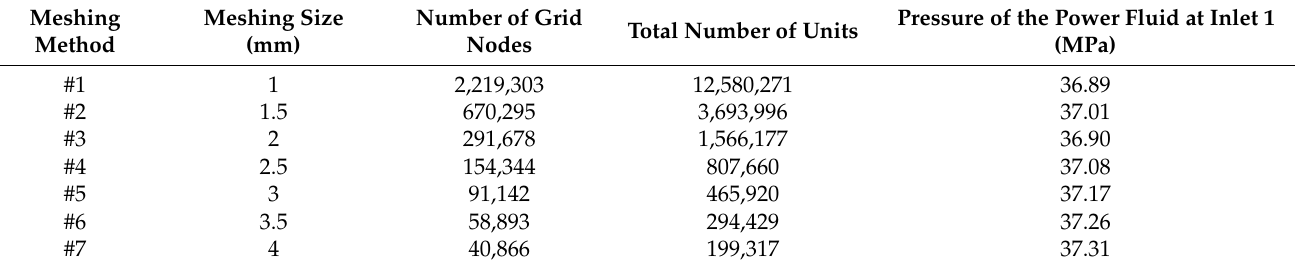
Table 1. Grid independence verification of simulation model.